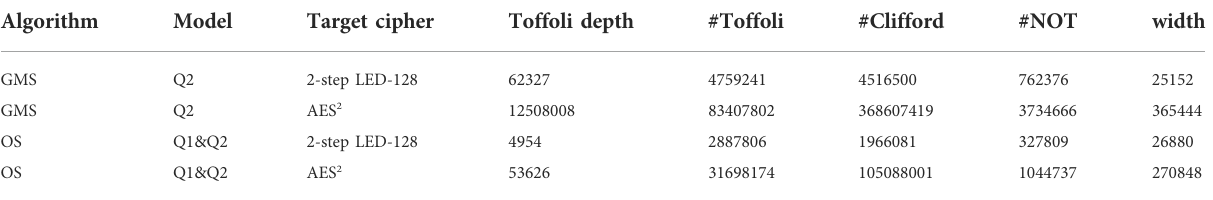
TABLE 6 Resource estimation for iterative oracle of GMS algorithm and OS algorithm, where Clifford gate denotes the CNOT gate and Hadamard gate.